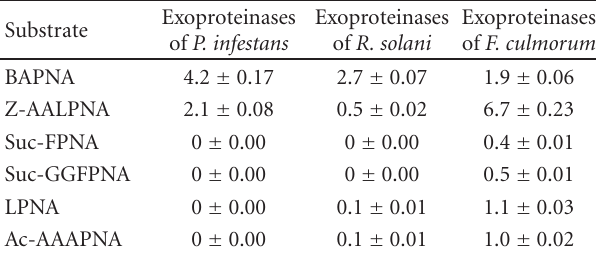
Table 2: Exoproteinase activity (U, nmol/mg of substrate per min- ute) of the oomycete P. infestans, fungi R. solani, and F. culmorum in hydrolysis of p- nitroanilides of amino acids and tripeptides (sub- strate concentration was 0.5 mM).